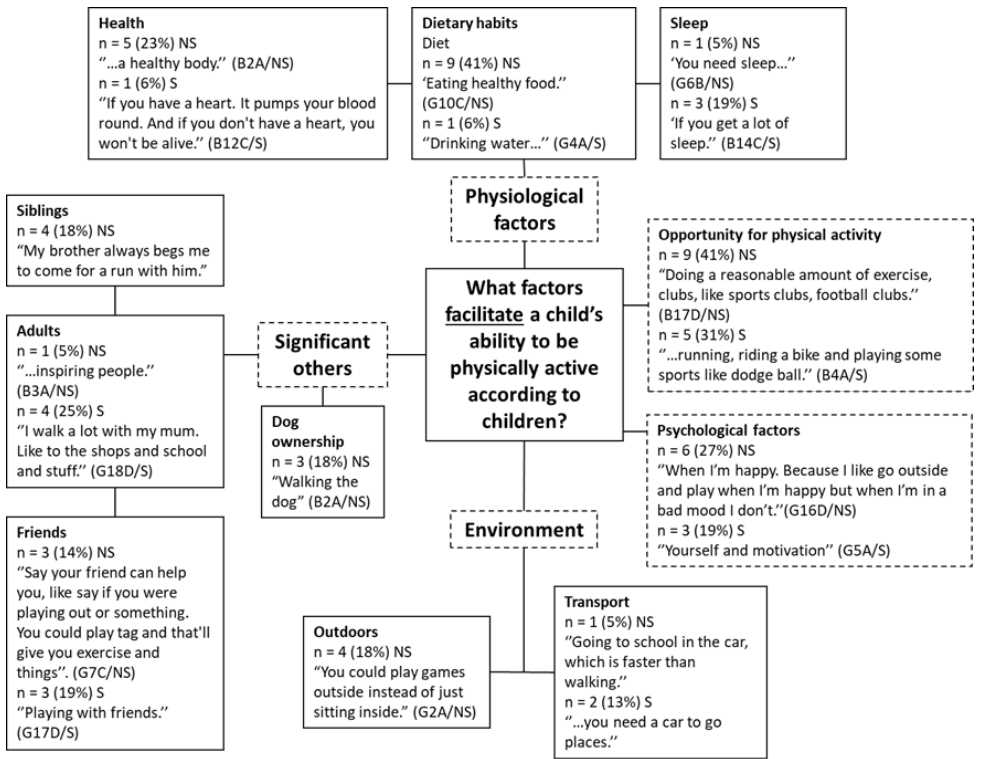
Figure 5. Pen profile demonstrating what factors facilitate a child’s ability to be physically active according to children from non-smoking (NS) and smoking (S) homes. Percentages represent the proportion of each group that contributed to the theme for children from smoking ( n = 16) and non-smoking homes ( n = 22).